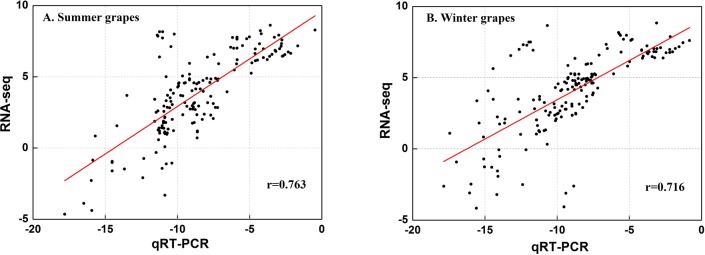
Validation of the gene expression results of qRT-PCR and RNA-seq in the summer crop (A) and winter crop (B). The data were obtained from fourteen unigenes at four developmental stages. The expression values of both qRT-PCR and RNA-seq were log2 transformed. Coefficients of linear regression were also calculated.